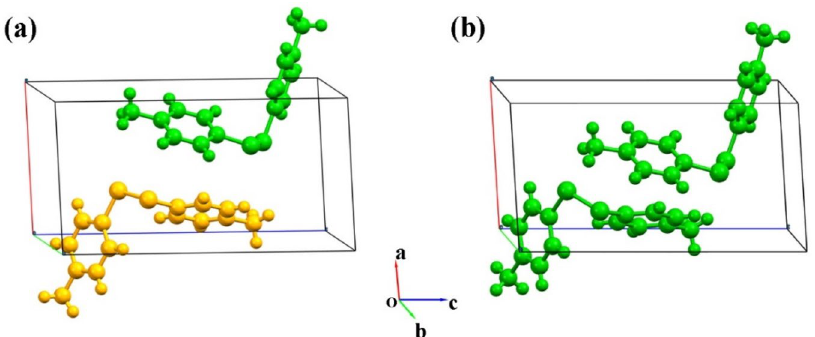
Figure 1. Crystal structures of p -Tol 2 S 2 . Phase α ( a ) has a space group of P2 1 , while phase β ( b ) has a space group of P 1 . The molecules are colored by the symmetry operation, where the unit cells of phase α and phase β contain one and two independent molecules,